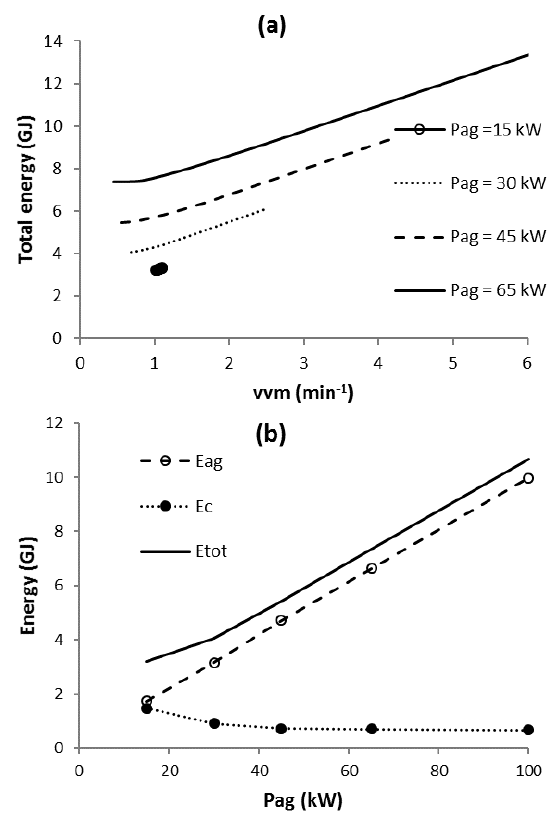
Figure 5. Scenario K: ( a ) Influence of vvm on total electric power for constant values of Pag ; ( b ) Influence of Pag on minimum total electric energy requirement ( Etot ) and corresponding agitator ( Eag ) and compressor ( Ec ) electric energy inputs.